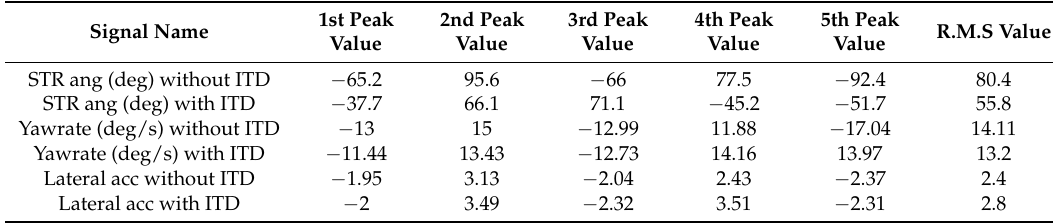
Table 3. Peak values of slalom test